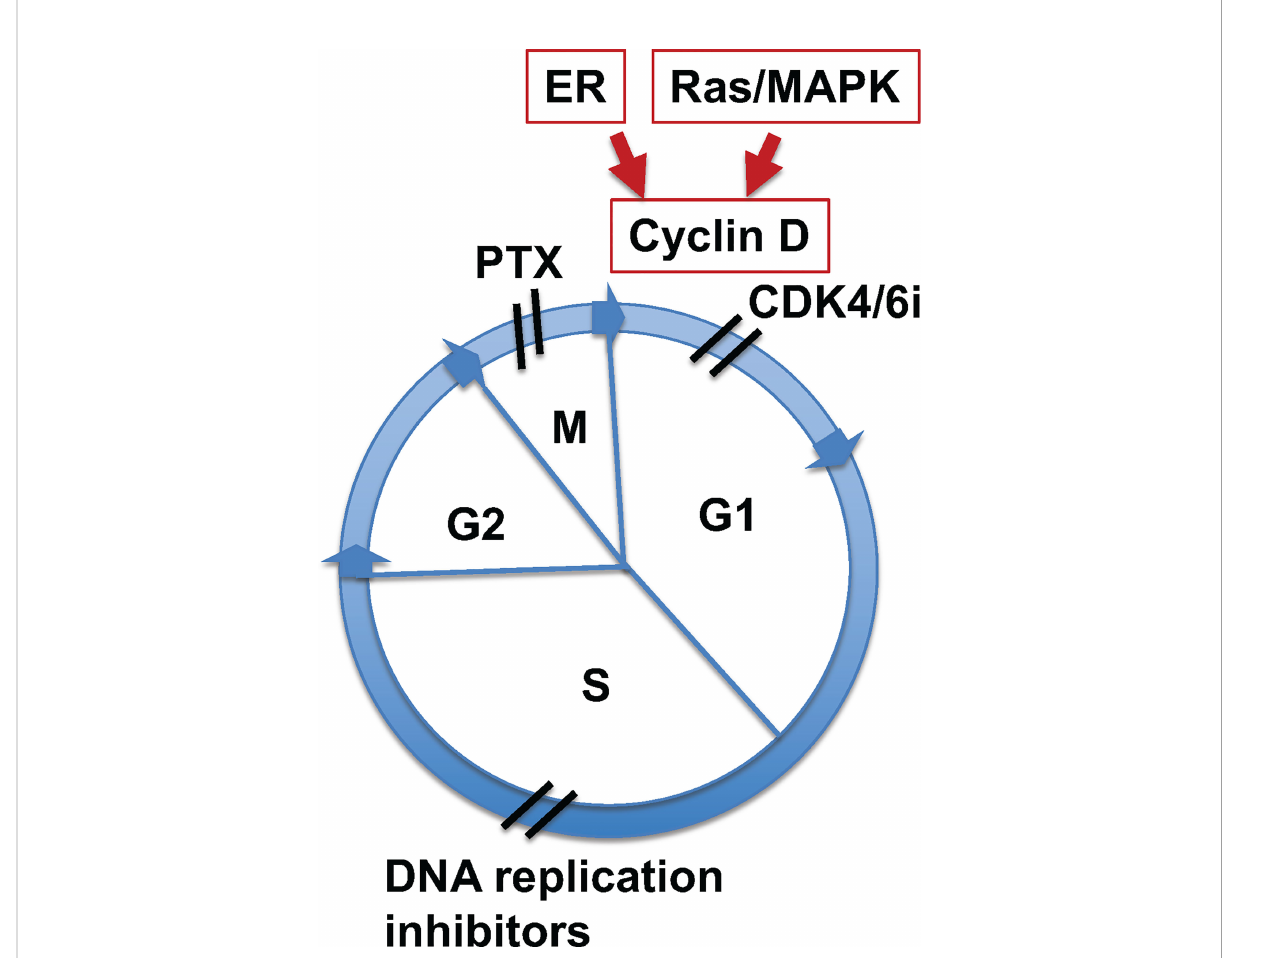
FIGURE 1 Paclitaxel and CDK4/6 inhibitors target different sites of the cell cycle. Illustration of sites of cell cycle targeted by paclitaxel and CDK4/6i. Mitogenic signaling by estrogen receptor (ER) or Ras/MAPK pathways induces cyclin D expression, which activates cyclin kinase 4 and 6 (CDK4/ 6) to initiate cell cycle through G1 phase. CDK4/6 inhibitors (CDK4/6i) block cycle kinase activities and arrest cells at early G1 phase. Paclitaxel (PTX) targets the function of spindle microtubules in cells at mitotic (M) phase, leading to aberrant mitosis and mitotic catastrophe. Additionally, mitotic inhibitors targeting DNA relication arrest cells at S